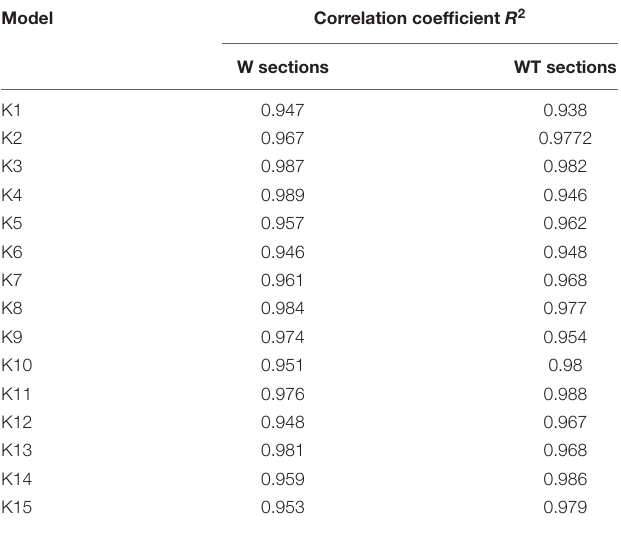
TABLE 2 | Correlation coefficient R 2 obtained based on the K-fold cross-validation method.